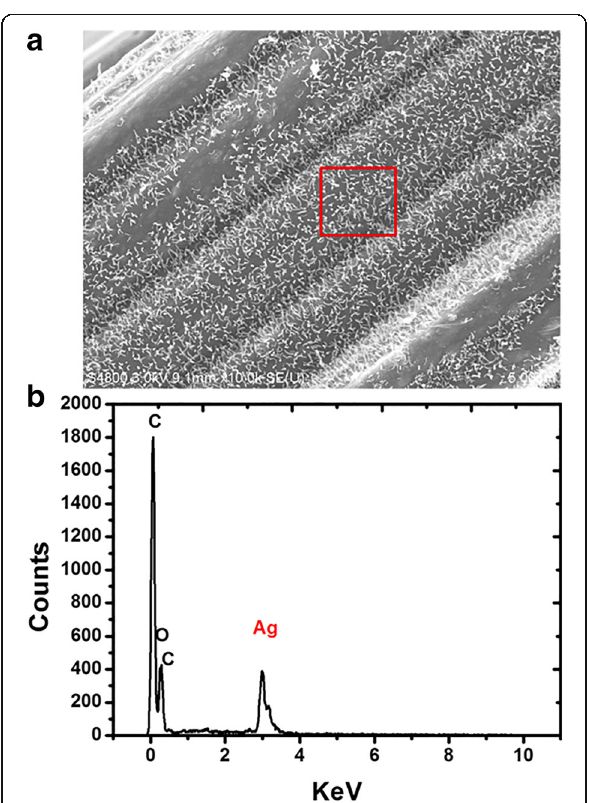
Fig. 4 a SEM image and b EDS of the Ag nanohair-grown